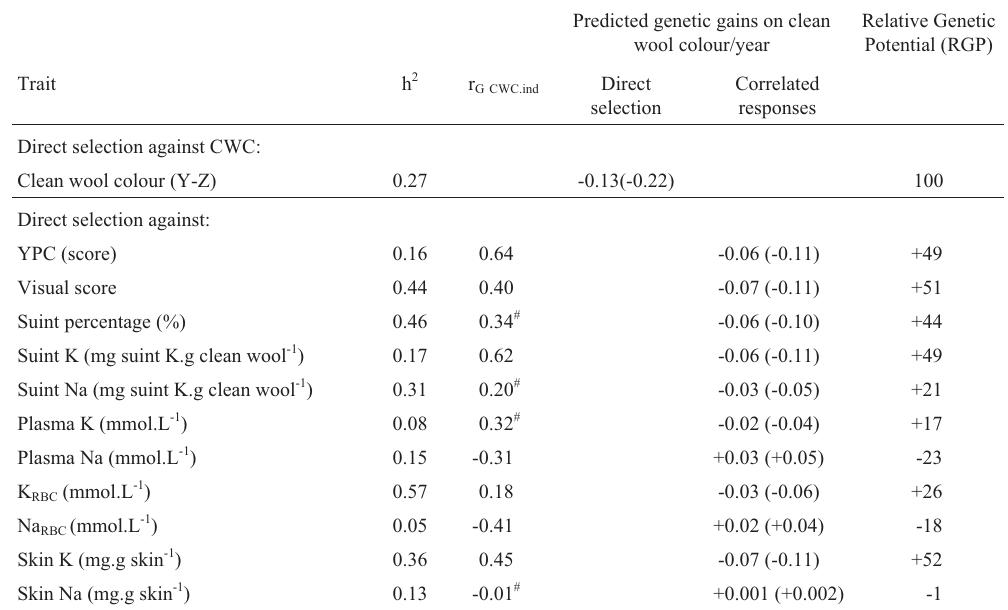
Table6 -Perannumexpectedcorrelatedresponsesoncleanwoolcolour(CWC)basedonindirectselectiononcolourandphysiologicaltraits.Correlated responses in units of standardised selection differential per generation are in